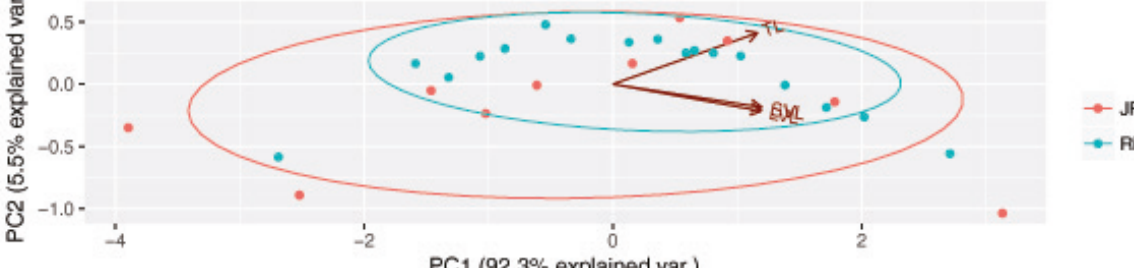
Figure 3. Graph of Principal Component Analysis (PCA) showing the variation of the snout-vent length (SVL), tail length (TL) and length of the vestigial hind limbs (LVL) (morphometric variables indicated by the brown arrow) in relation to the population variation (Ritápolis specimens in blue and Juiz de Fora specimens in pink) from Ophiodes striatus (n =